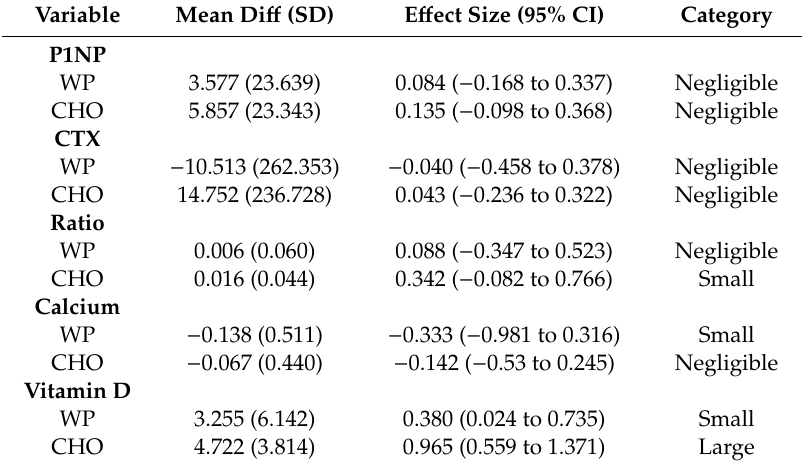
Table 3. Summary of e ff ect sizes for supplement groups across each physiological